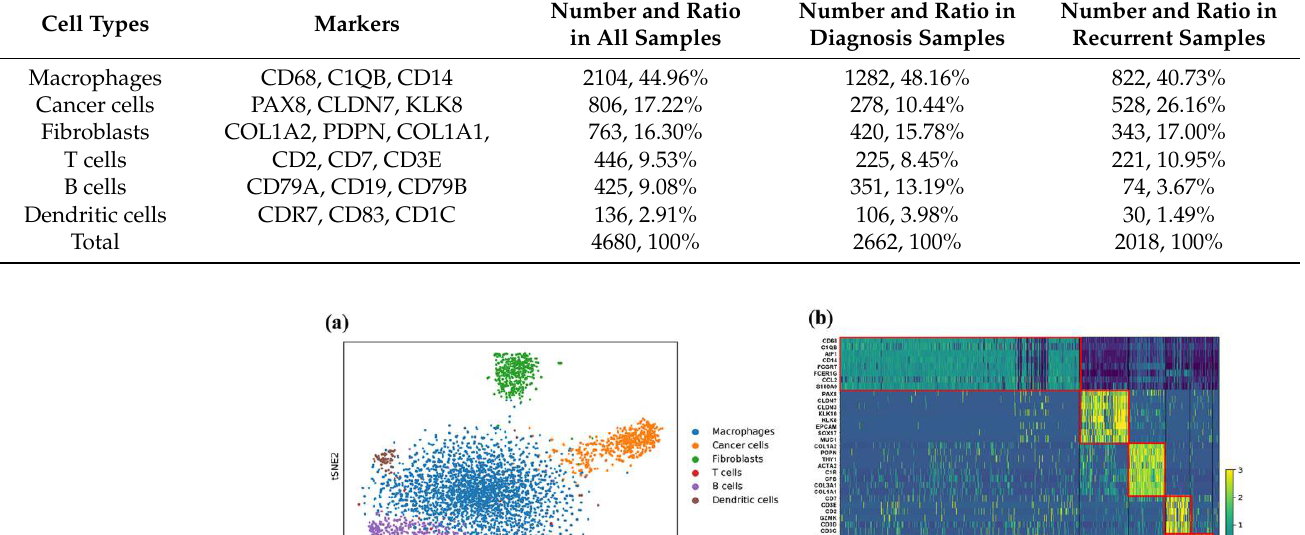
Table 2. Cell markers for cell population identification and cell type distribution in diagnostic and recurrent samples of EOC malignant ascites.